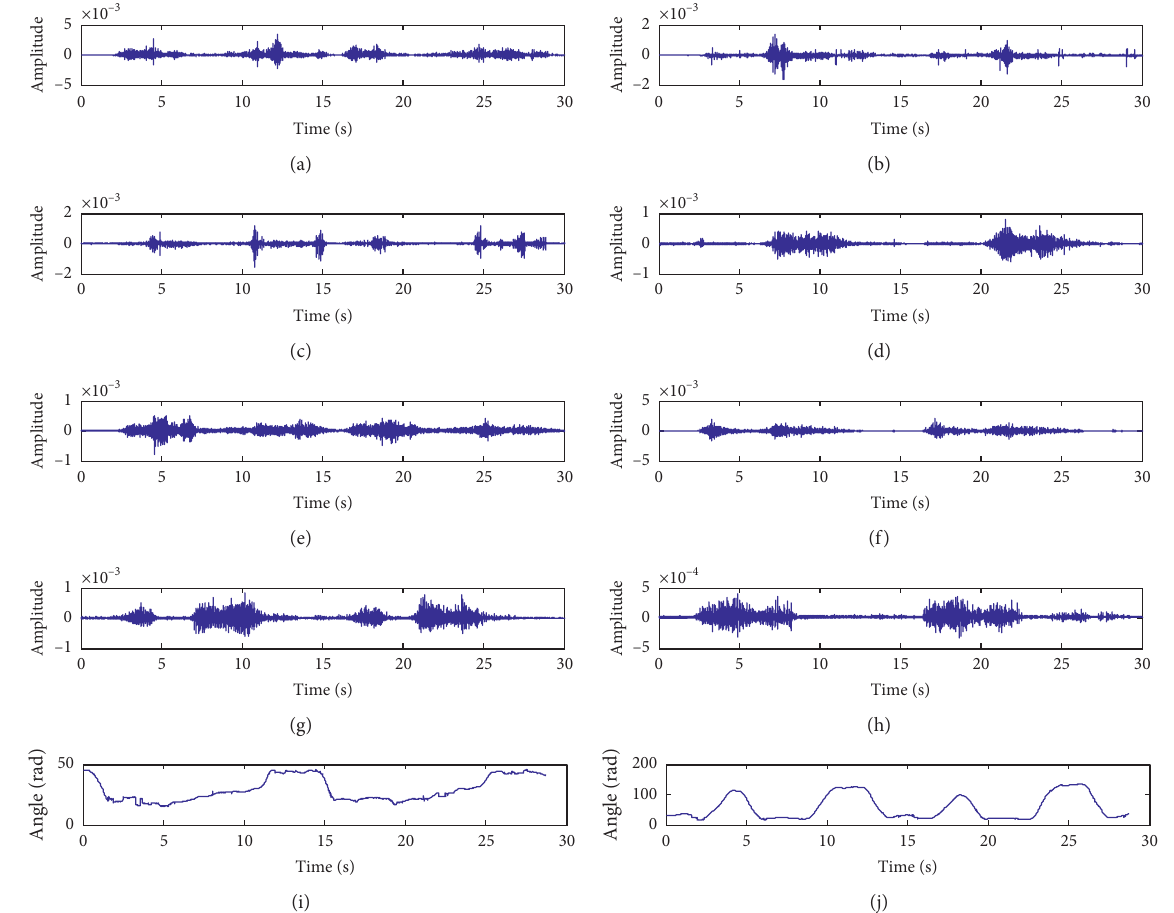
Figure 6: (a–h) sEMG signals from BB, TB, BR, TZ, TM, AD, LD, and PM. (i) Angle signal of shoulder joint. (j) Angle signal of elbow joint